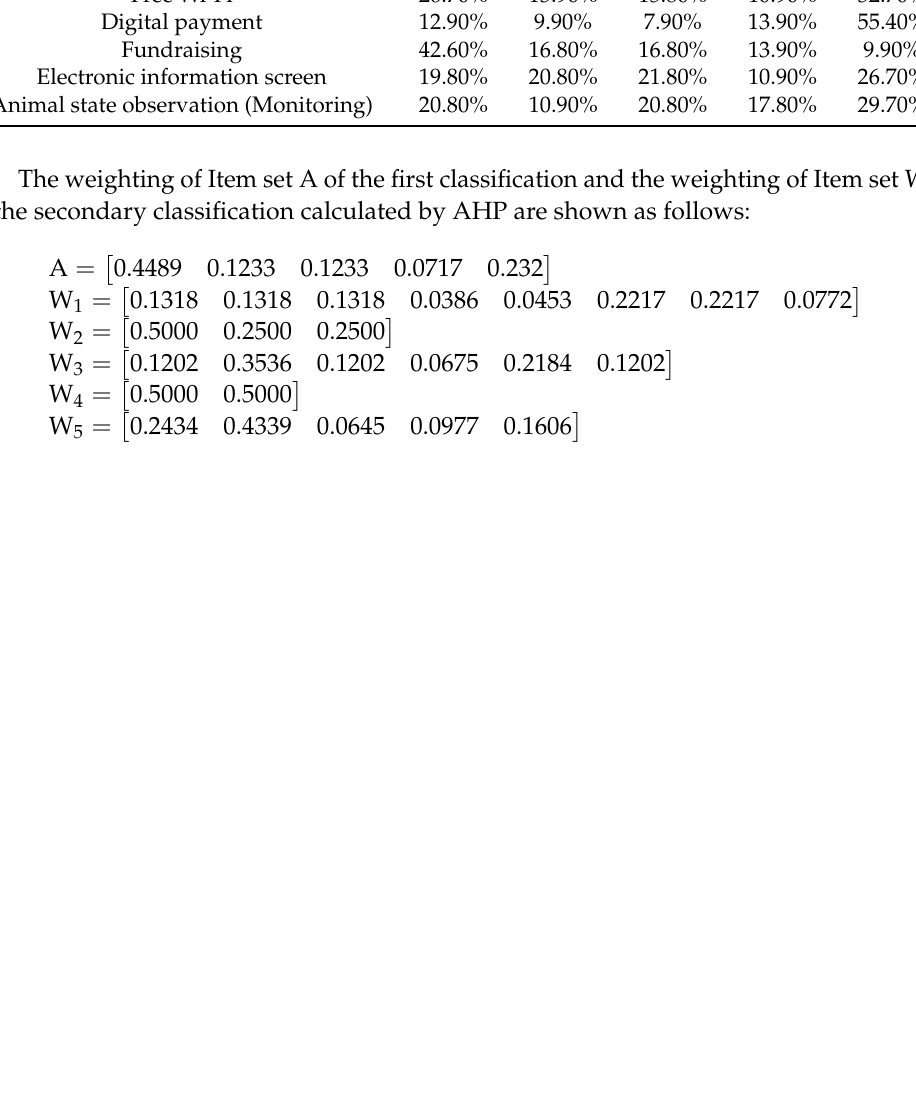
Table 14. Results (Performance) of the second-level questionnaire (Functions within the zoo).